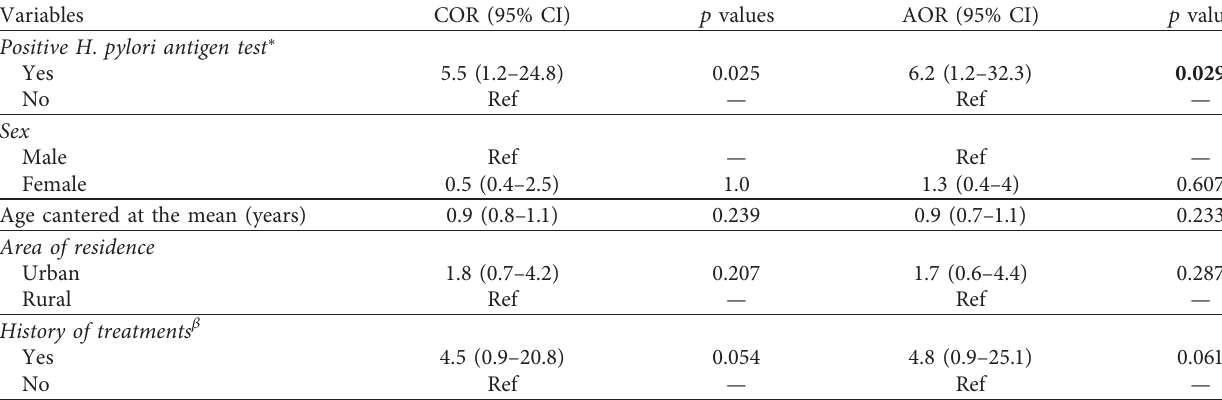
Table 3: Odds of association between CU and H . pylori ( n �